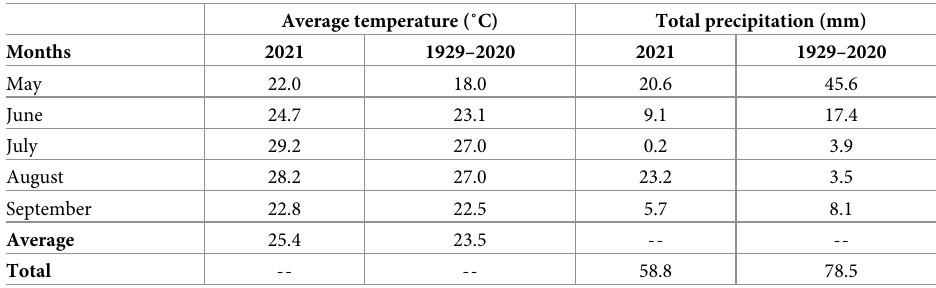
Table 2. Climatic data for the research sites (1929–2021).